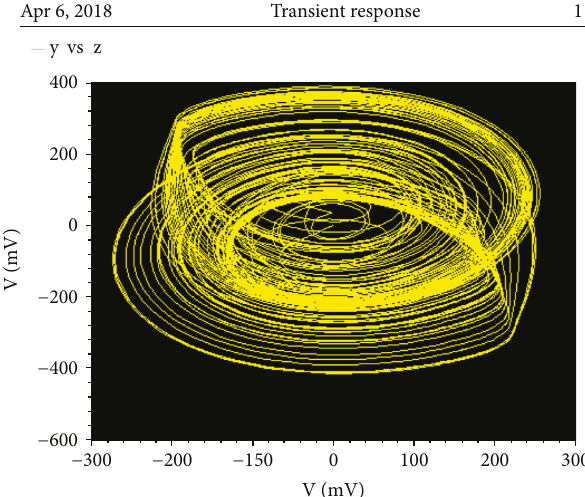
is turned on, S 2